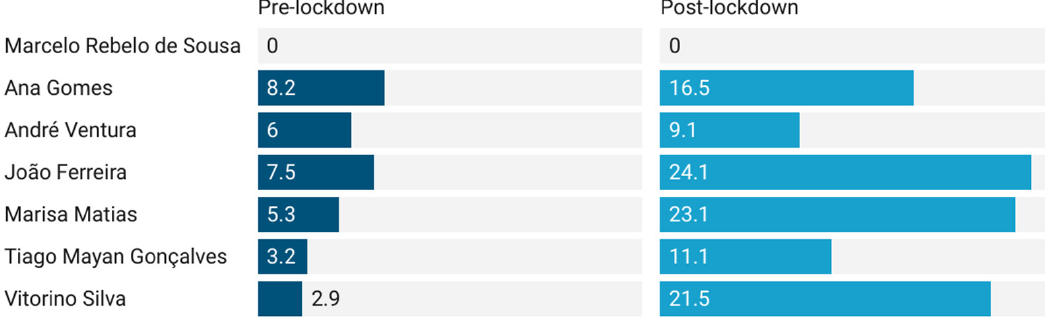
Figure 5. Online campaigning before and after the January 2021 lockdown was declared (average number of daily posts on social media). Source: Own data (see Section 3.1.2).